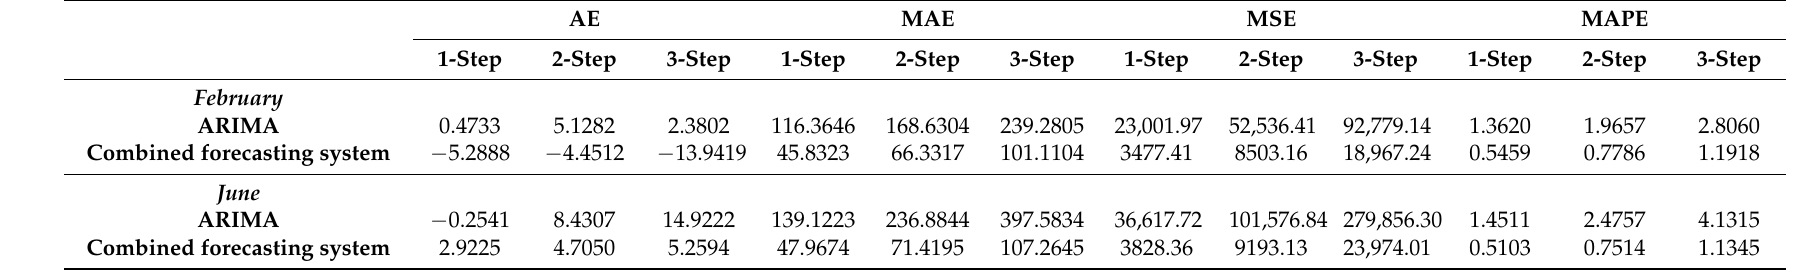
Table 10. Forecasting results of the proposed combined forecasting system and ARIMA